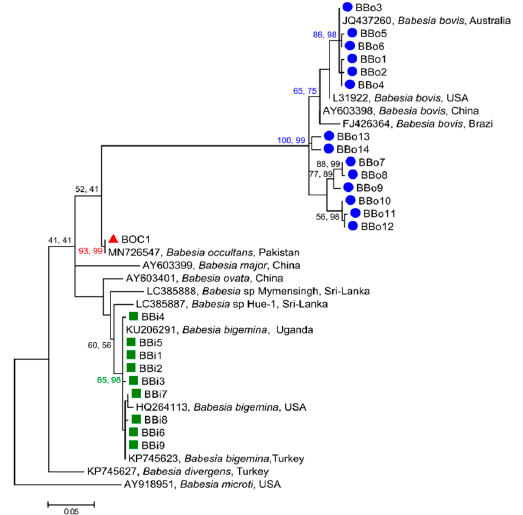
Figure 2. Phylogenetic relationships of amplicon sequence variants (ASVs) of Babesia species determined in this study (coloured symbols) with reference sequences from previous studies. The relationships were inferred based on separate analyses of 18S rRNA sequence data (aligned over 386 bp) using the Maximum Likelihood (ML) and Neighbor-Joining (NJ) methods. Babesia microti (AY918951) was used as outgroup. Nodal support values are indicated as bootstrap values for the NJ (first) and ML (second) method. The scale bar indicates distance.